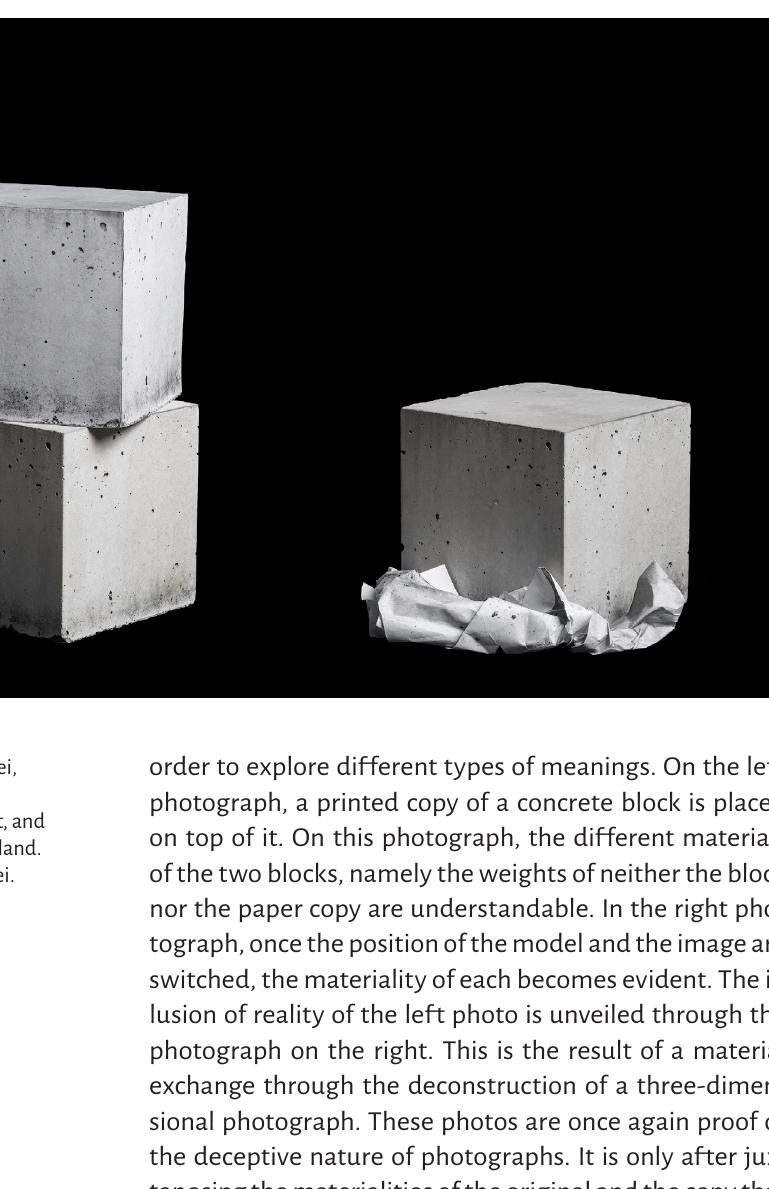
317 www.img-network.it